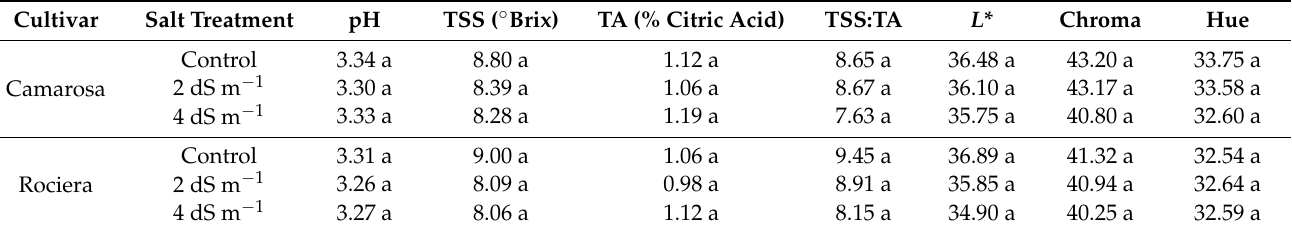
Table 5. Effect of salt stress on the strawberry fruit juice pH, total soluble solids (TSS), titratable acidity (TA), the ratio of total soluble solids:titratable acidity and on the strawberry fruit color attributes ( L *, chroma and Hue